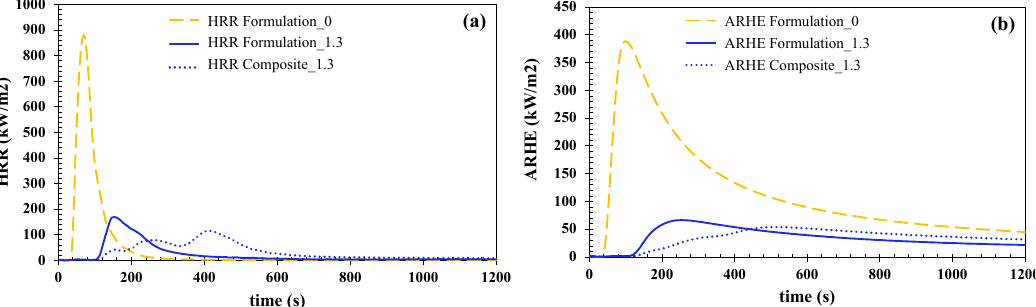
Figure 6. Heat Release Rate (HRR) ( a ) and Average Rate of Heat Emission (ARHE) ( b ) evolution over time for the tested formulations and composite as a function of time.